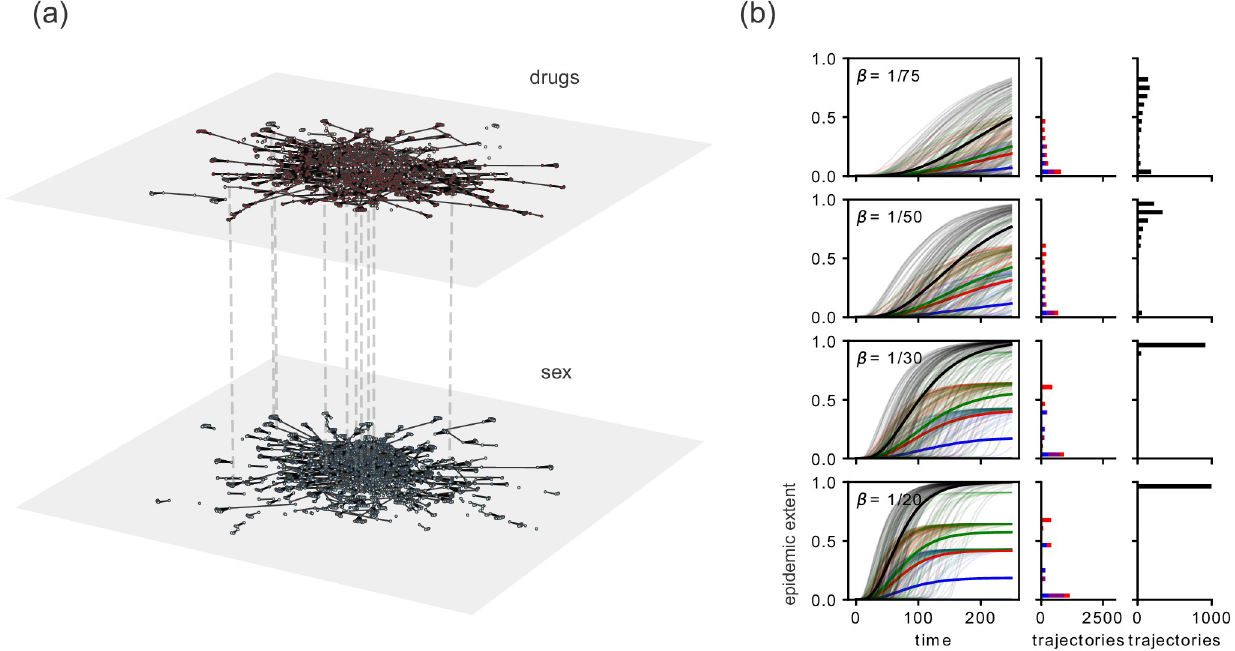
Fig 2. Comparing the epidemic extent for different choices of network data for the Project 90 data set. (a) A network visualization of the Project 90 data set. The dashed lines are not exhaustive, but illustrate that the nodes in each layer are identical. The lightly colored nodes in each layer are disconnected from the largest connected component in that layer. One can see that each layer in this multiplex network has different contact structure. (b) The SI model simulated on the Project 90 data. The left panel displays a plot of the epidemic extent with respect to time for the uniplex sex network (blue), uniplex drug and needle network (red), the union of uniplex networks (green), and the multiplexed data (black). The thick lines indicate the average epidemic extent and the thin lines are a random sample of 100 individual realizations of this model. The center column illustrates the histogram of epidemic extents for the number of nodes solely accessed from the sex network (blue), the drug network (red), and both (magenta). The right column illustrates the distribution of epidemic extents for the multiplexed data.